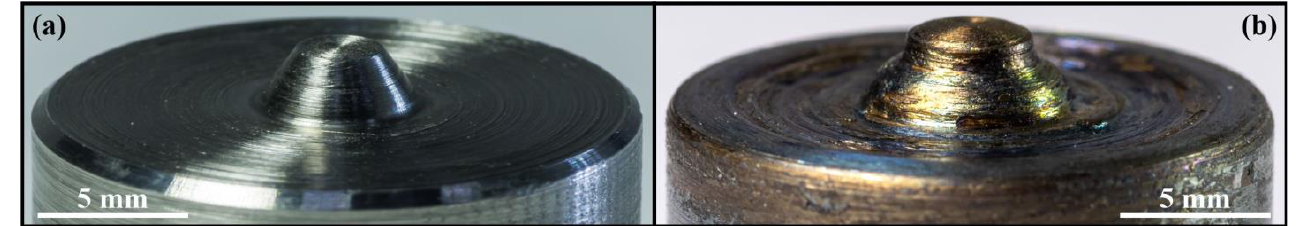
Figure 22. FSW tool produced from alloy ZhS6U before welding ( a ) and after ≈0.5 m of welding ( b ).